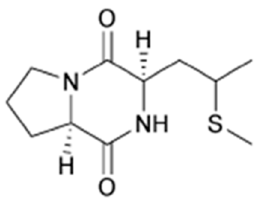
Figure 2. A bioactive compound, cyclo( L -proline- L -methionine), produced by P. aeruginosa [97].